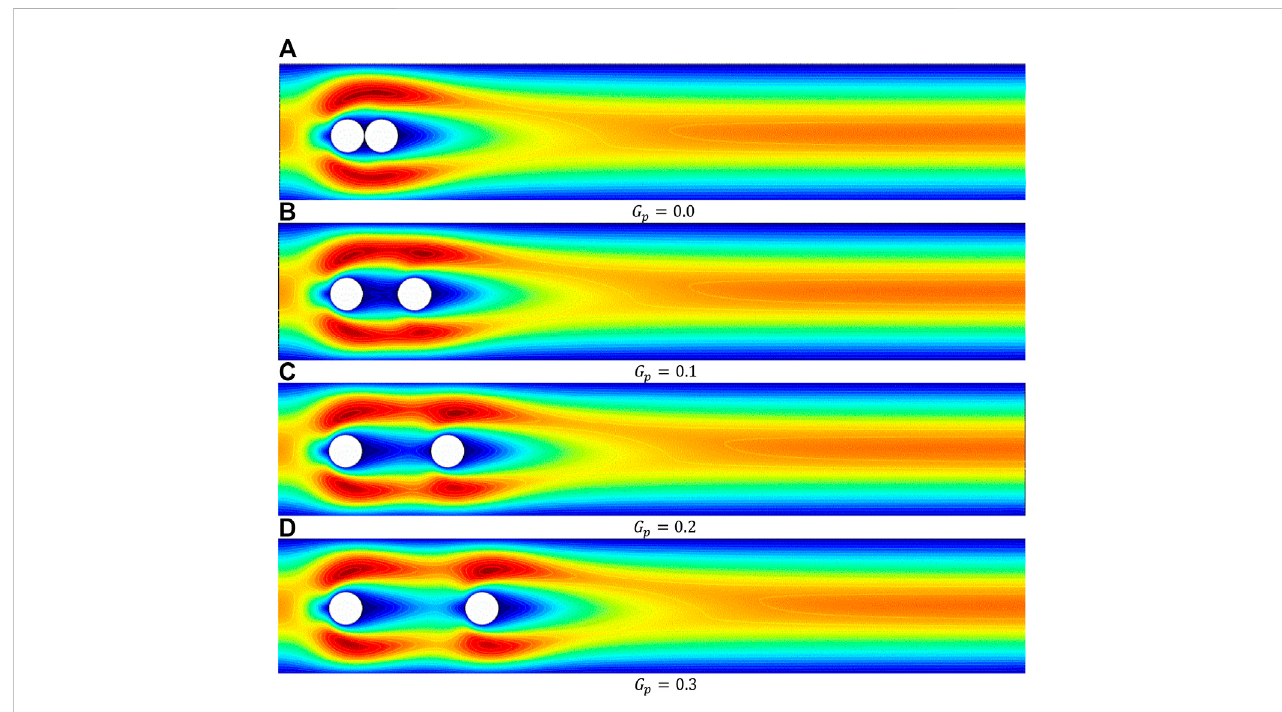
FIGURE 8 In fl uence on velocity for various gap spacings of a cylinder with n (cid:2) 1 . 5 and Re (cid:2) 20.